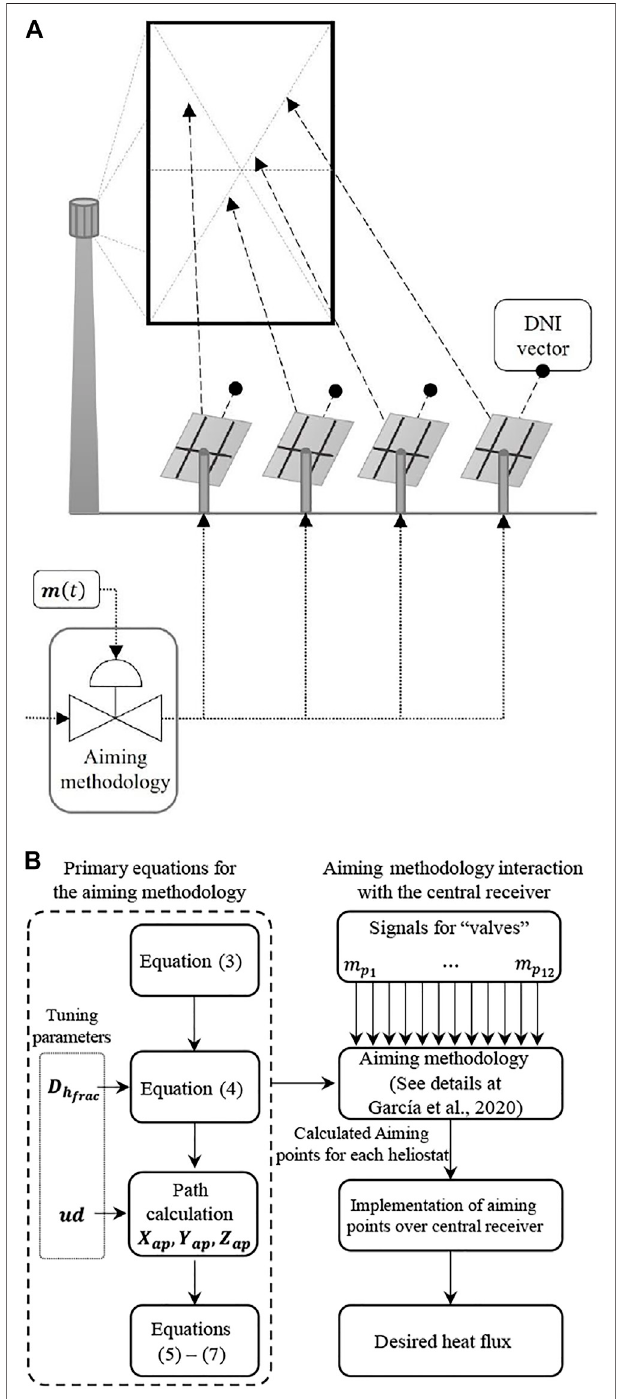
FIGURE 3 | (A) Aiming methodology representation using the valve analogy. Adapted from (García et al., 2020) (B) Primary relations among equations within the aiming methodology calculation